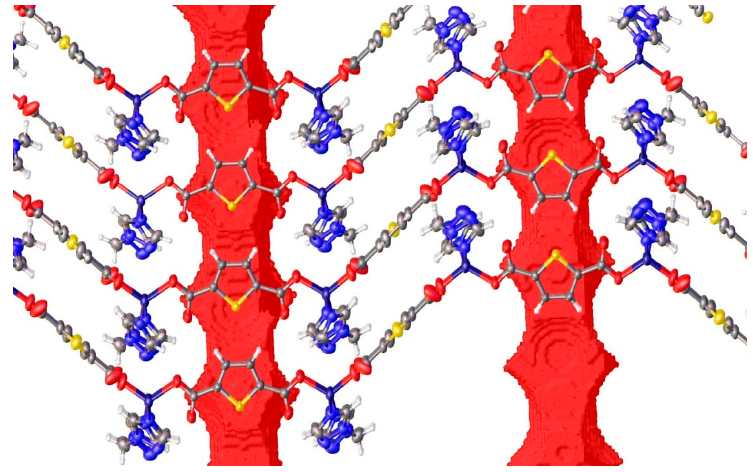
Figure 3. Representation of channel voids in the structure of the complex [Zn(tdc)(btrm)] ∙ nDMF ( 1 ).